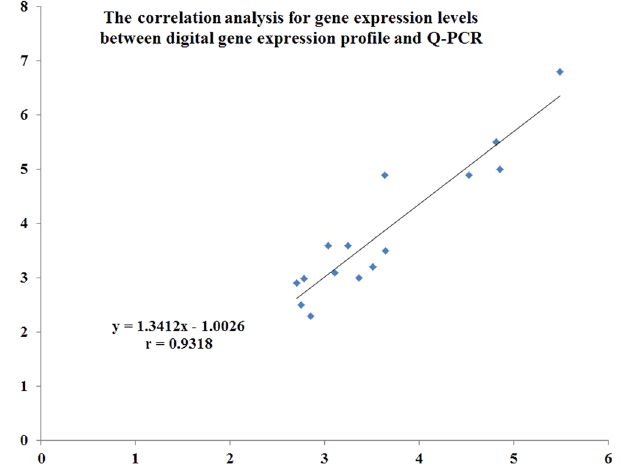
Figure 4. Technical validation of digital gene expression profile results by q-PCR. The r value (r = 0.932) indicates Spearman’s Correlation between the 2 methods.